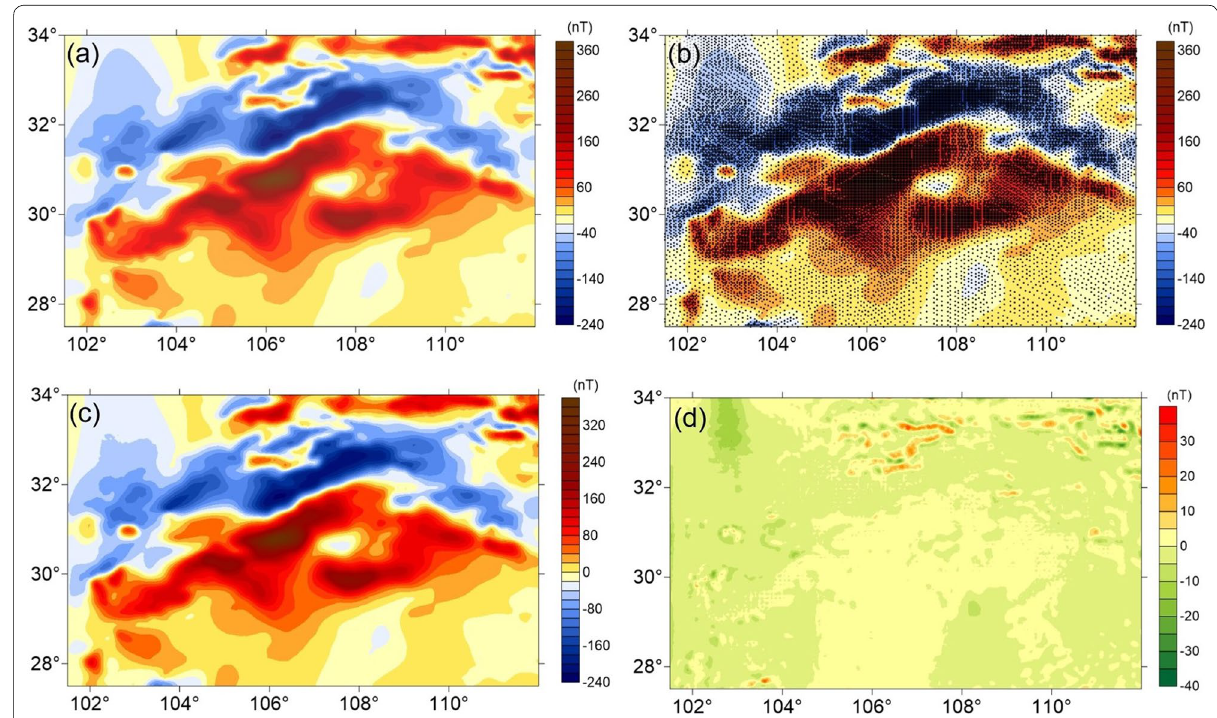
Fig. 3 The magnetic data for 3D inversion. a The observed total-field magnetic data in Sichuan Basin. It is the same as Fig. 2a. b The locations of the magnetic data points after adaptive down-sampling. These data points are marked by black dots on the observed magnetic data. c The calculated magnetic data by our inverted model. d The misfit between the observed magnetic data in a and the calculated magnetic data in